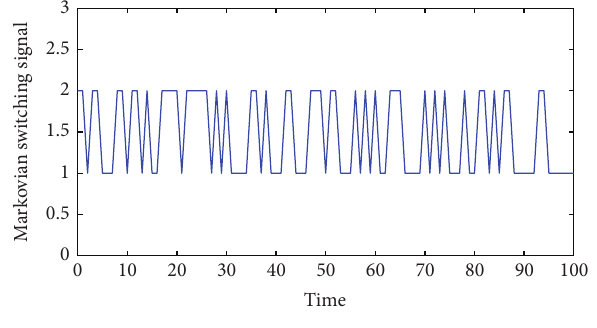
Figure 1: Markovian switching signal.